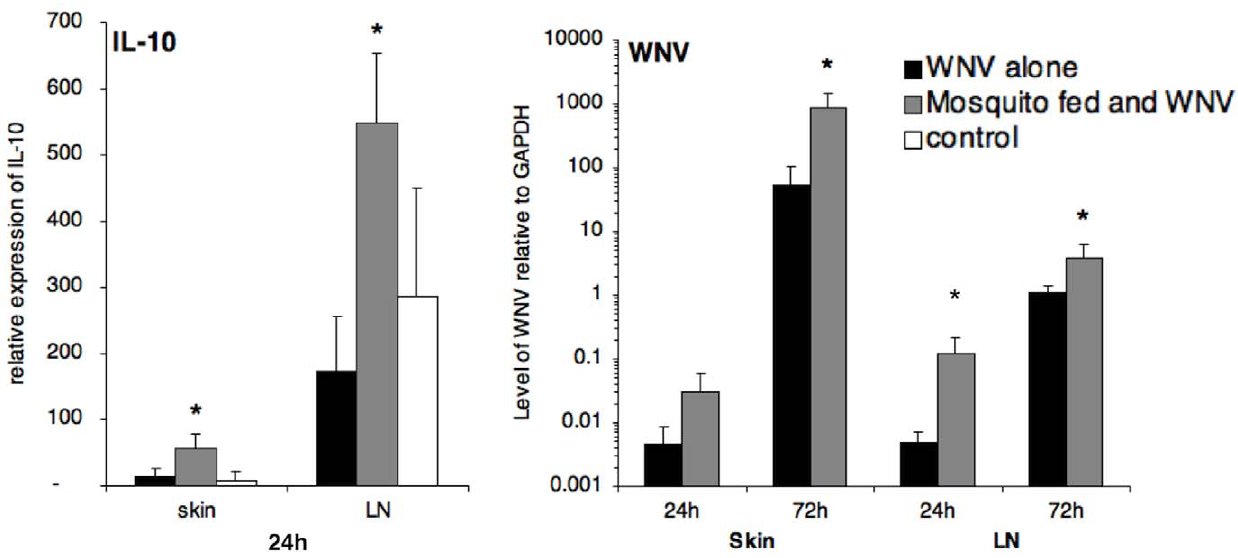
Figure 5. IL-10 and WNV RNA levels in the skin and draining lymph nodes following intradermal inoculation with 10 4 pfu of WNV in 10 m l of PBS. RNA levels were assessed by real-time RT-PCR at 24 and 72 h post-infection and normalized to those of the GAPDH gene. The means 6 standard deviation are shown, and an asterisk signifies a statistically significant difference (p , 0.05) as compared to the group infected with WNV alone as determined by Mann-Whitney test. Control groups were mock infected with PBS alone. n=5/group; displayed results are representative of two experimental replicates.